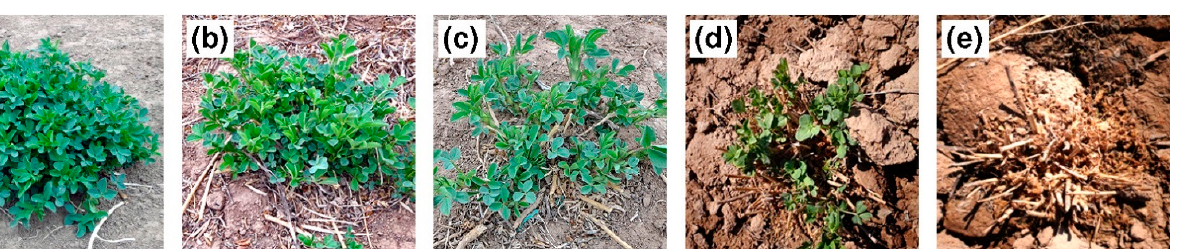
Figure 2. Examples showing alfalfa plant morphology per average scoring index (ASI) grade: ( a ) Grade 1; ( b ) Grade 2; ( c ) Grade 3; ( d ) Grade 4; and ( e ) Grade 5.